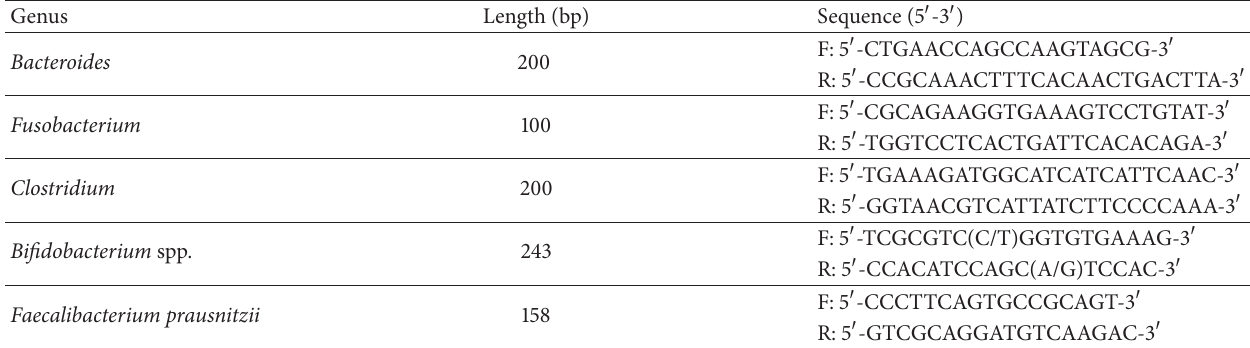
Table 3: Primer sequences for 16S